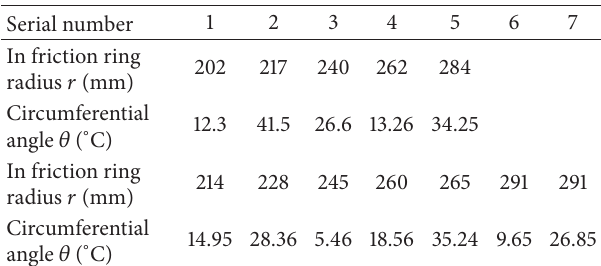
Table 8: Data of optimized pad structure.